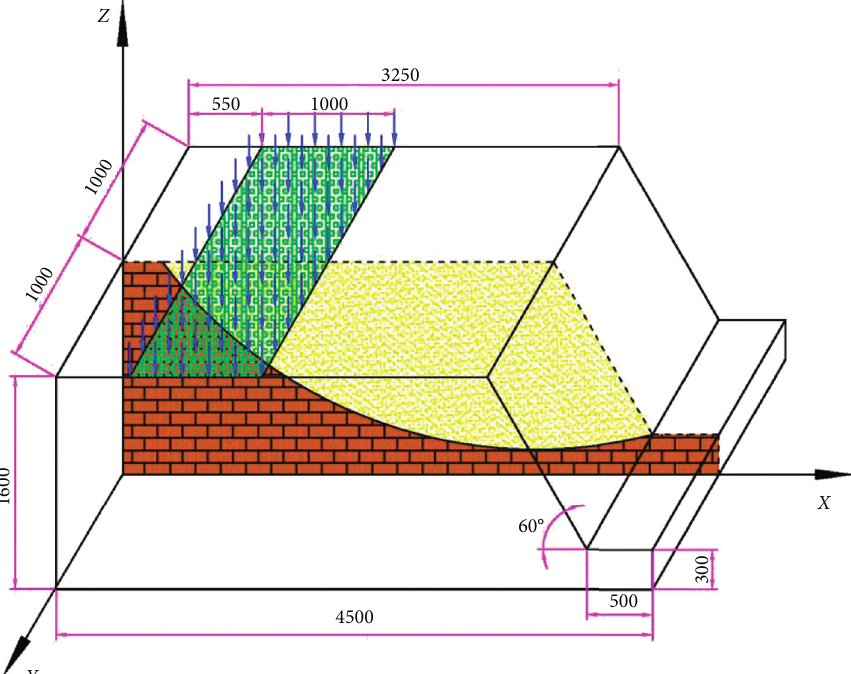
Figure 1: Configuration, loading position, and monitoring plane of the model slope (unit: mm). The model slope lies above the horizontal plane x y with z being a vertical coordinate, directed upward.